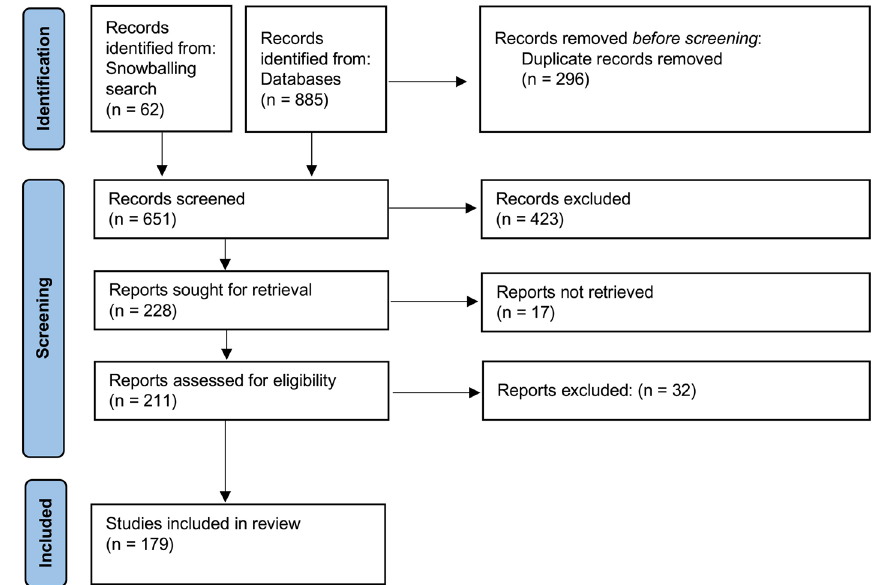
Fig. 2 Flowchart of the systematic search and selection process following the Prisma statement